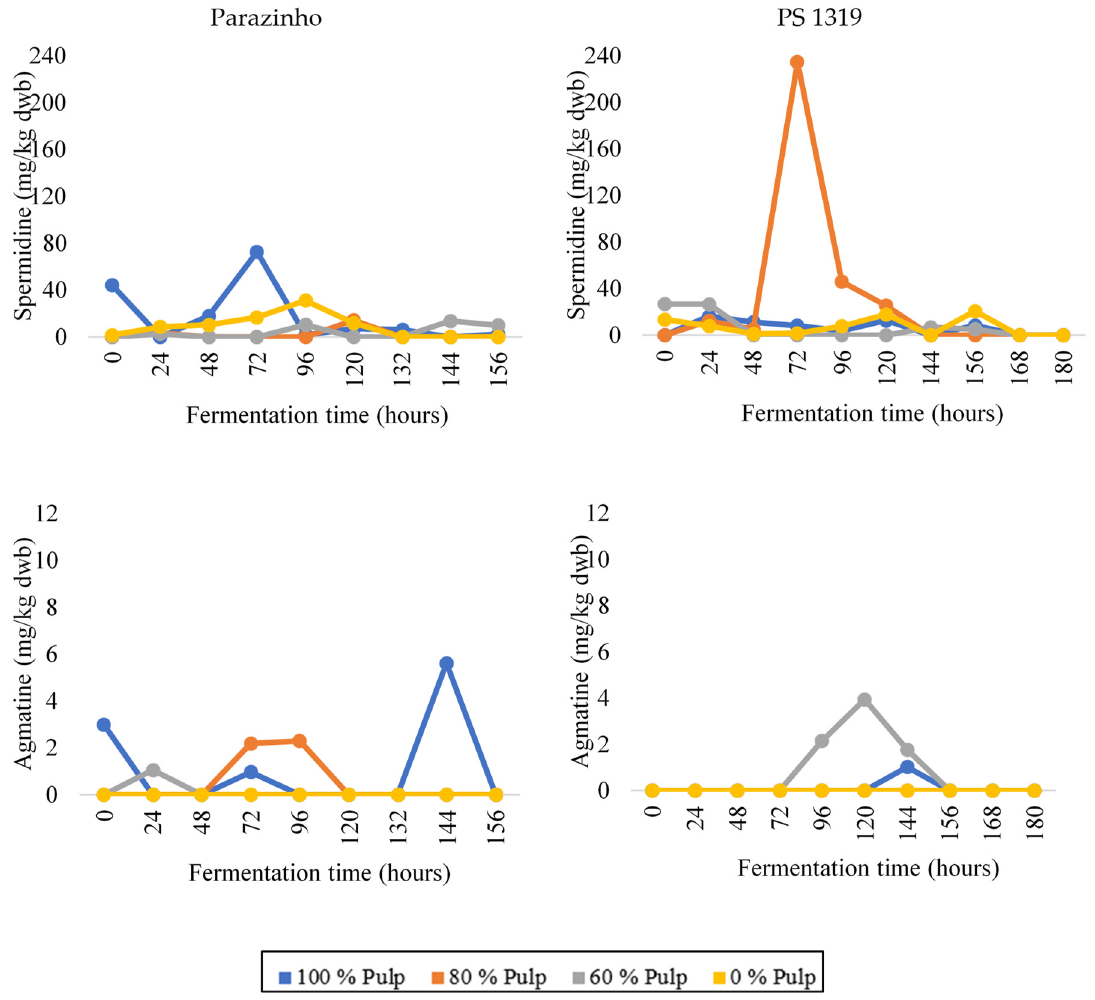
Figure 4. Changes in the levels of the polyamines—spermidine and agmatine—during on-farm fermentation of two varieties of cocoa (PS 1319 and Parazinho) from Bahia, Brazil, using different proportions of pulp (100, 80, 60, and 0%).